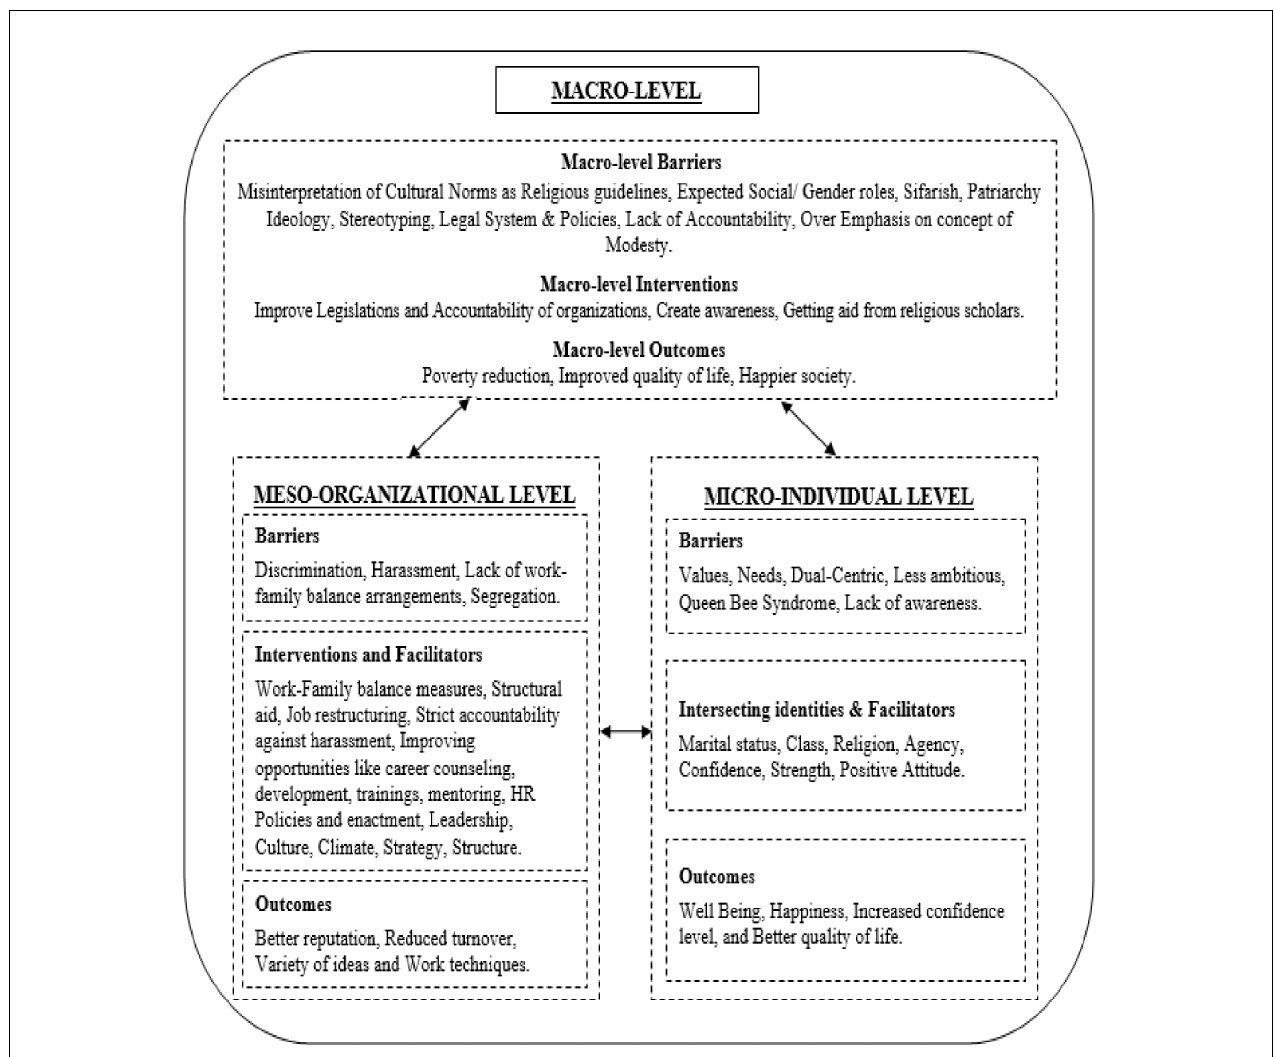
FIGURE 1 | Multi-level interaction of factors related to workplace gender parity in